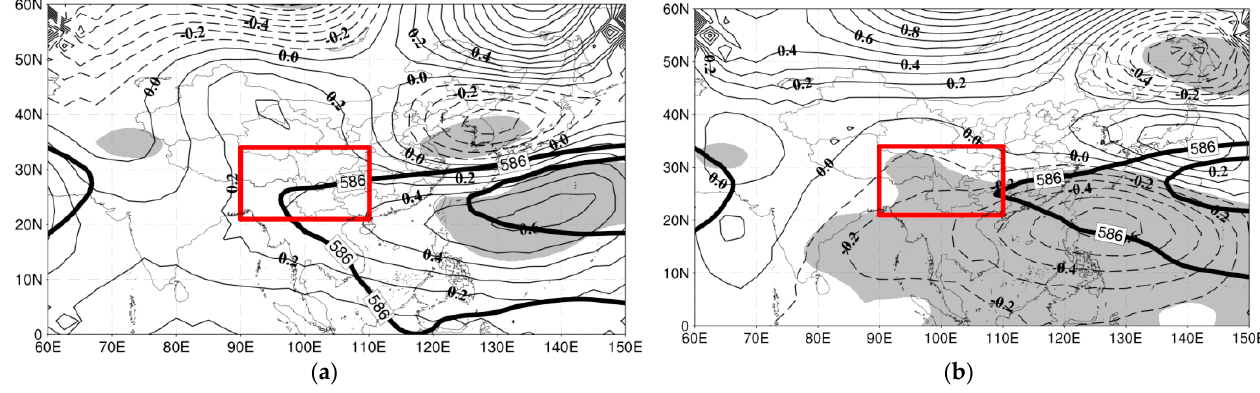
Figure 14. Anomalies of 500 hPa resultant height field in summer of strong and weak East Asian subtropical monsoon surge years. (Unit: dagpm; shadow area passes 95% significance test; area in red box is southwest China.) ( a ): Strong years; ( b ): weak years.